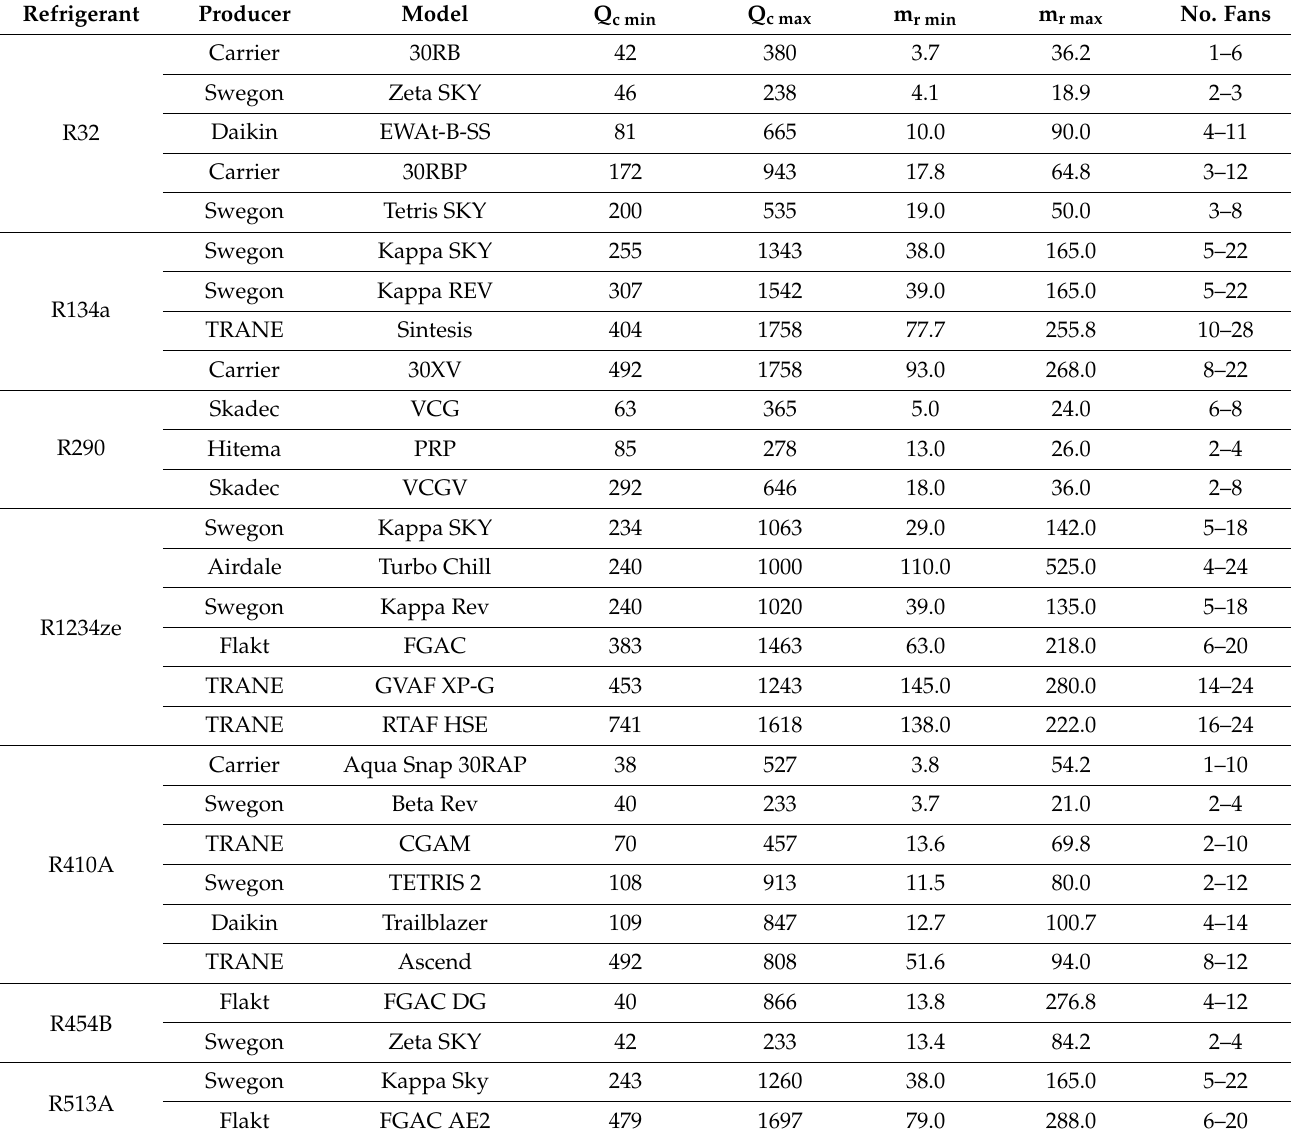
Table 4. List of devices with the scope of the declared power, the number of fans, and a refrigerant